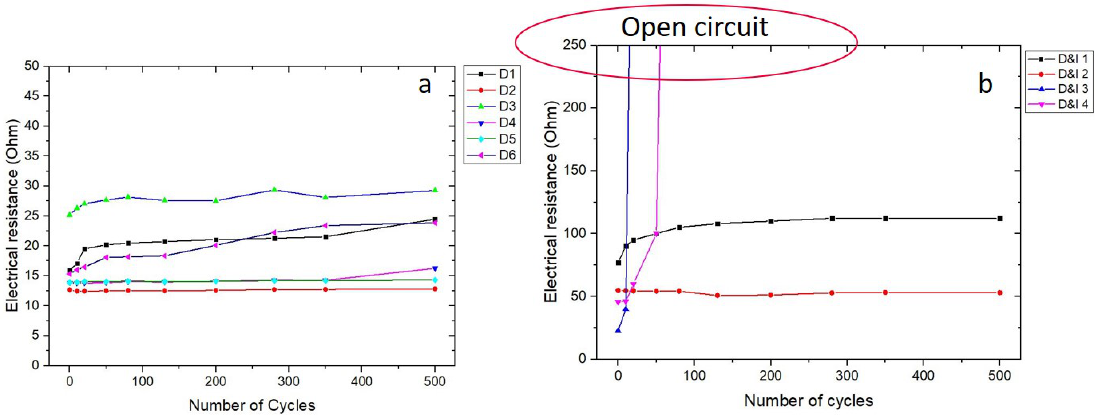
Figure 10. Temperature cycling test results of double-layer Ag lines without ( a ) and with ( b ) insulating ramp.